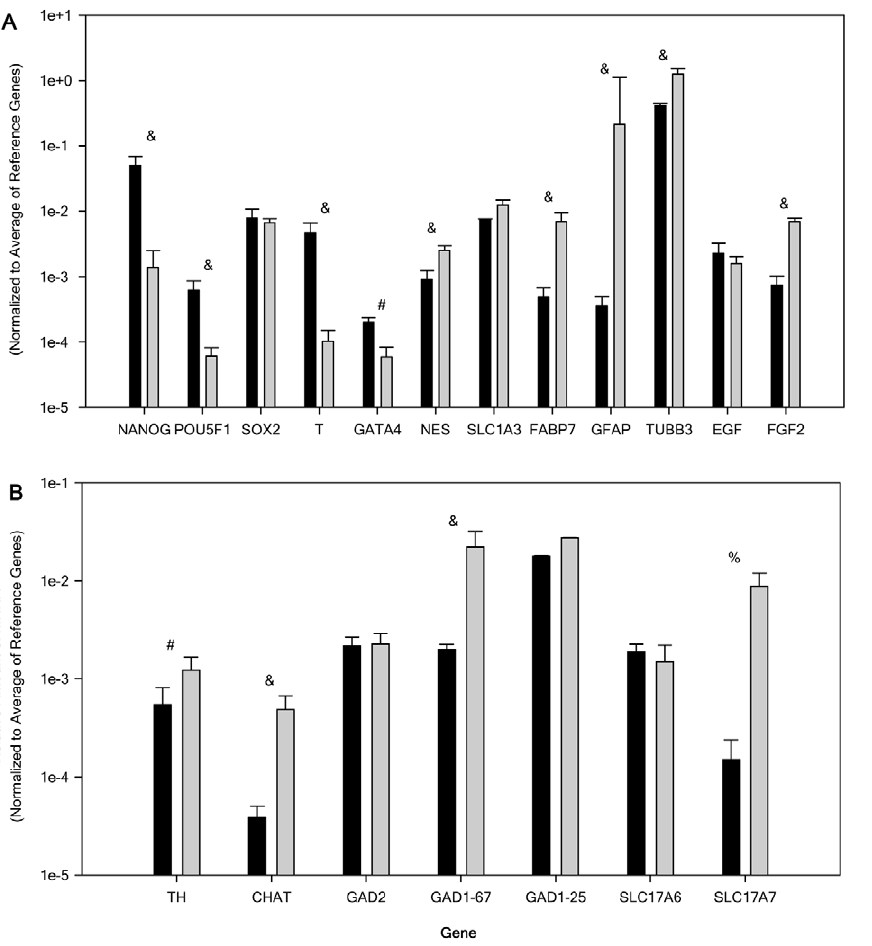
Figure 4. Relative mRNA expression of cell marker genes and neurotransmitter related genes expressed by NTERA2 (NT2) and NTERA2 all-trans retinoic acid differentiated neurons (NT2N). Relative amount of mRNA normalized to the average of 3 reference genes (G3PDH, PPIA, and NUBP1). Relative amount of mRNA for NT2 (black bar) and NT2N (gray bars) were obtained from 6 passage matched cultures (ranging from 25–36) and all samples were analyzed independently in triplicate. Panel A displays the expression of ‘stemness’, dermal layer, cell type makers, and growth factor genes. Panel B displays the relative expression of neurotransmitter related genes. All data are expressed as the average relative gene expression + SEM. For the comparison of NT2 to NT2N: # p , 0.05, % , p , 0.01, and & p ,